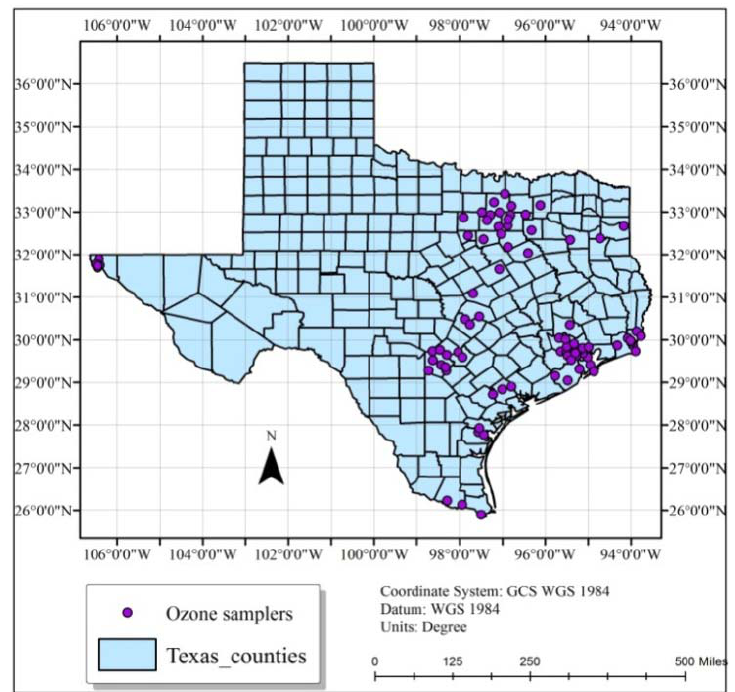
sampling stations in 3